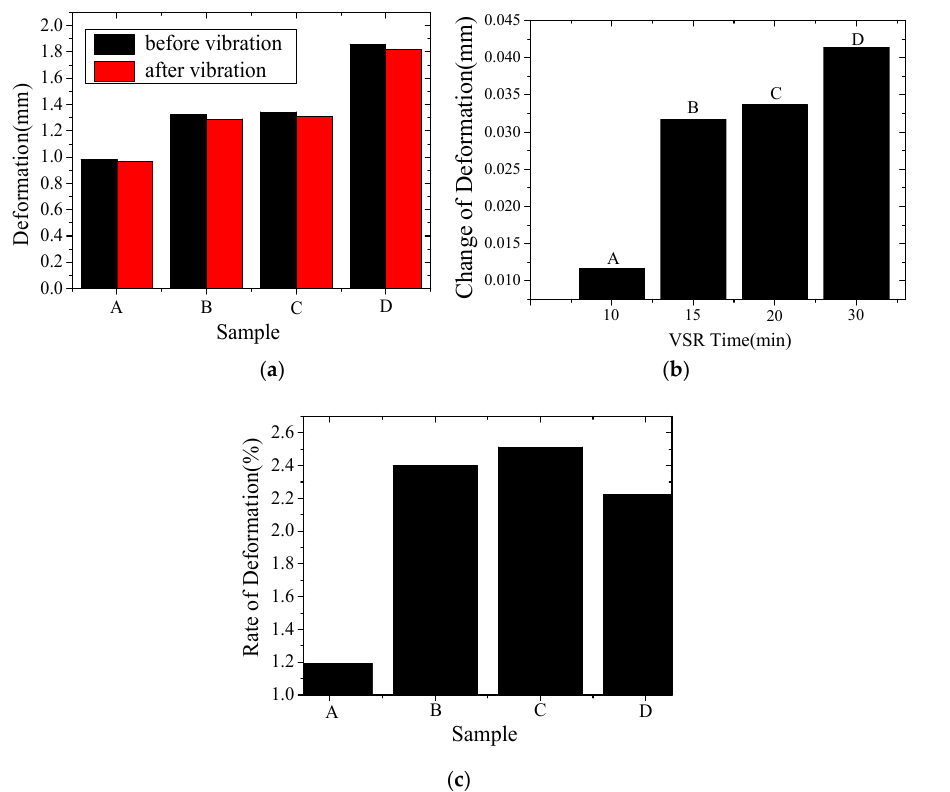
Figure 13. Deformation comparison after vibration stress relief and machining. ( a ) Deformation; ( b ) change of deformation induced by VSR; ( c ) change in the rate of deformation.